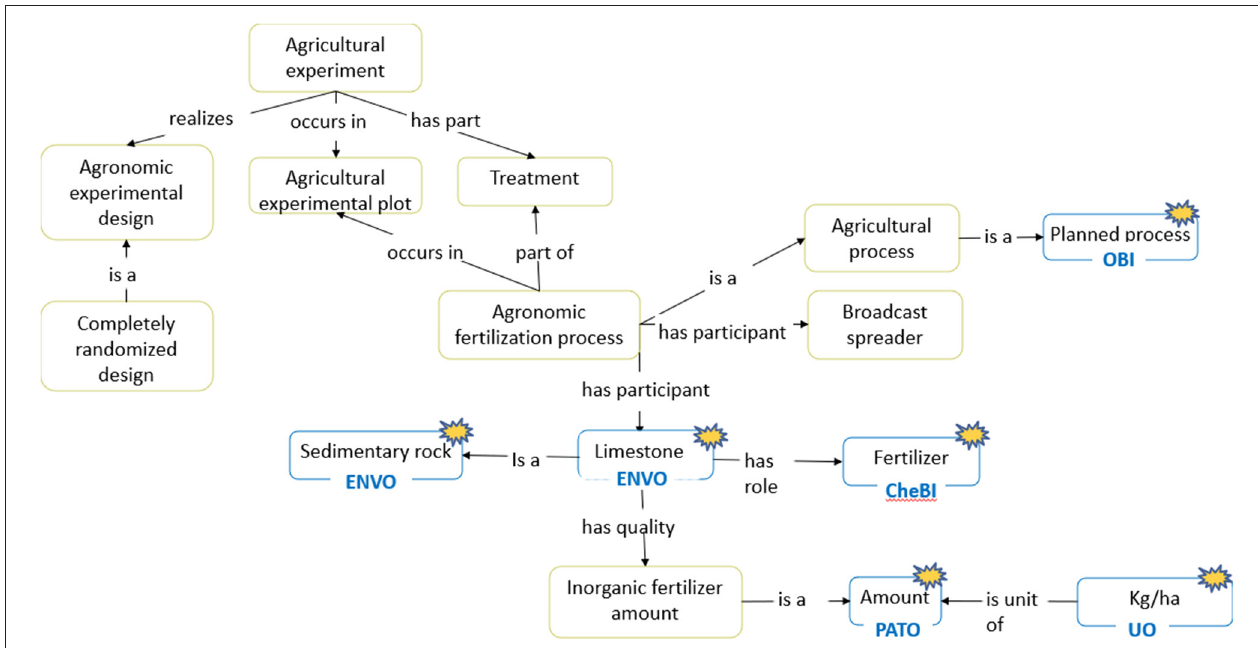
FIGURE 6 | A small part of the Agronomy Ontology, showing key relationships and hierarchies, and reliance on terms from other ontologies (asterisked, and in